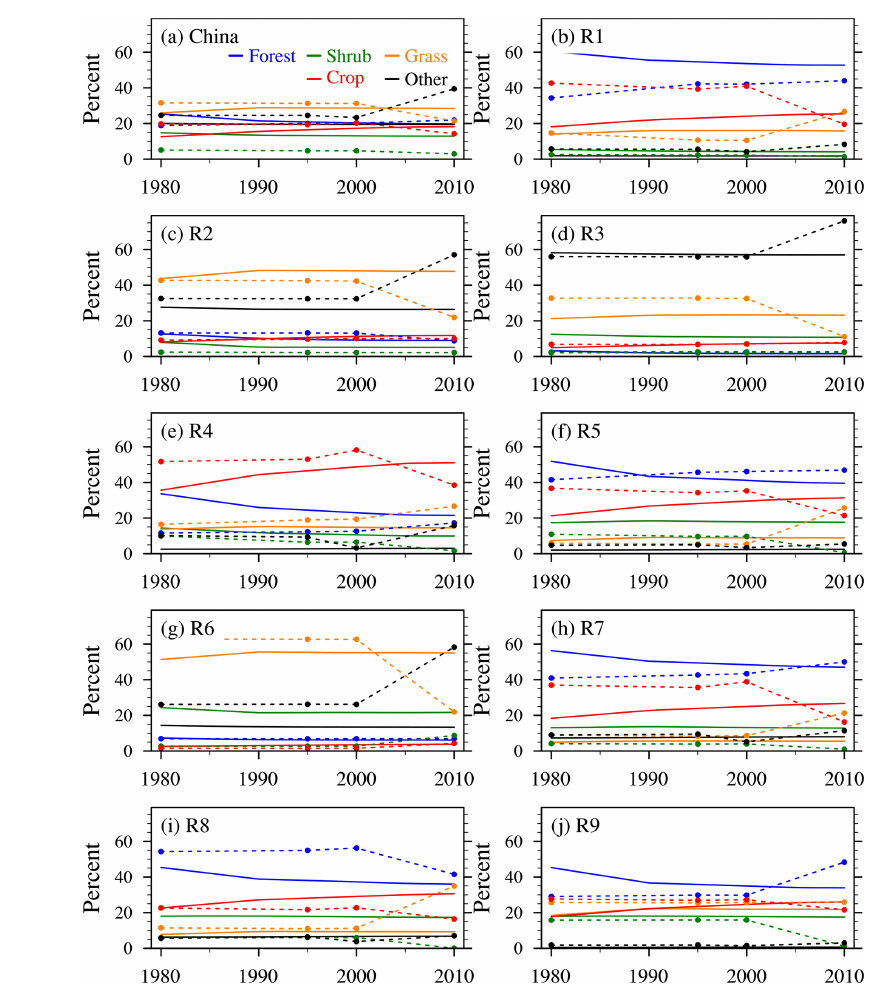
Figure 8. Interannual changes of vegetation types over China and nine subregions between 1981 and 2010 from the MsTMIP (solid lines) and the China Land Use/Cover Dataset (dashed lines with dots). Other includes SNICE (snow and ice), water and bare